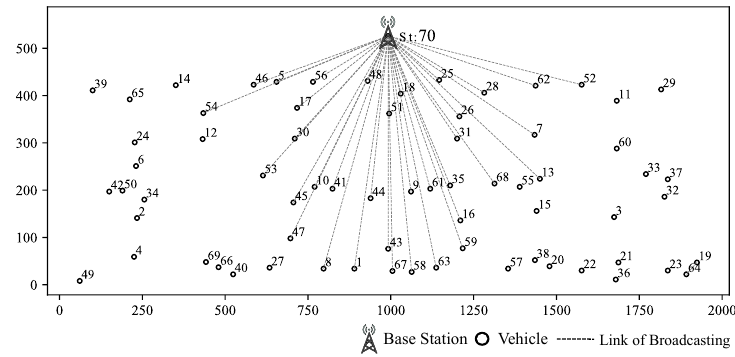
Figure 13. Sessions Base Station Participated. Table 5. Percentage of Base Station Participation in